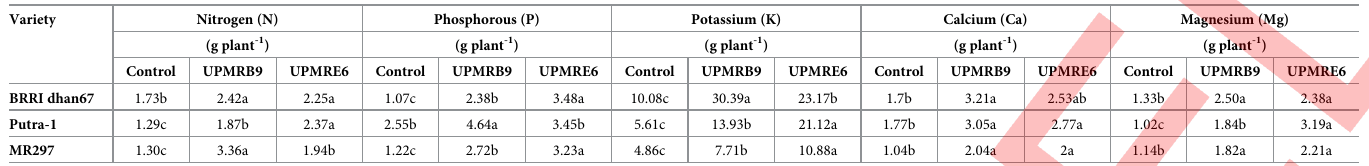
Table 2. Effect of bacteria inoculation on nutrient uptake in rice varieties under salt stress. Variety Nitrogen(N)